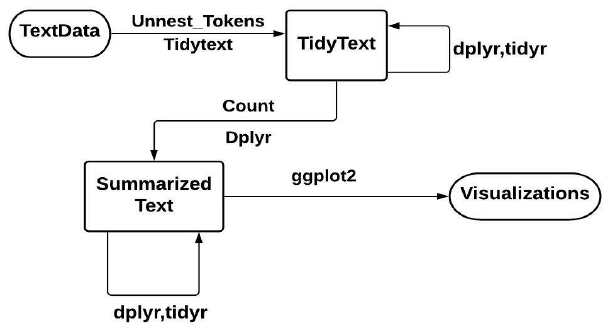
Figure 1. Flowchart representation of typical text analysis using principles of tidy data.